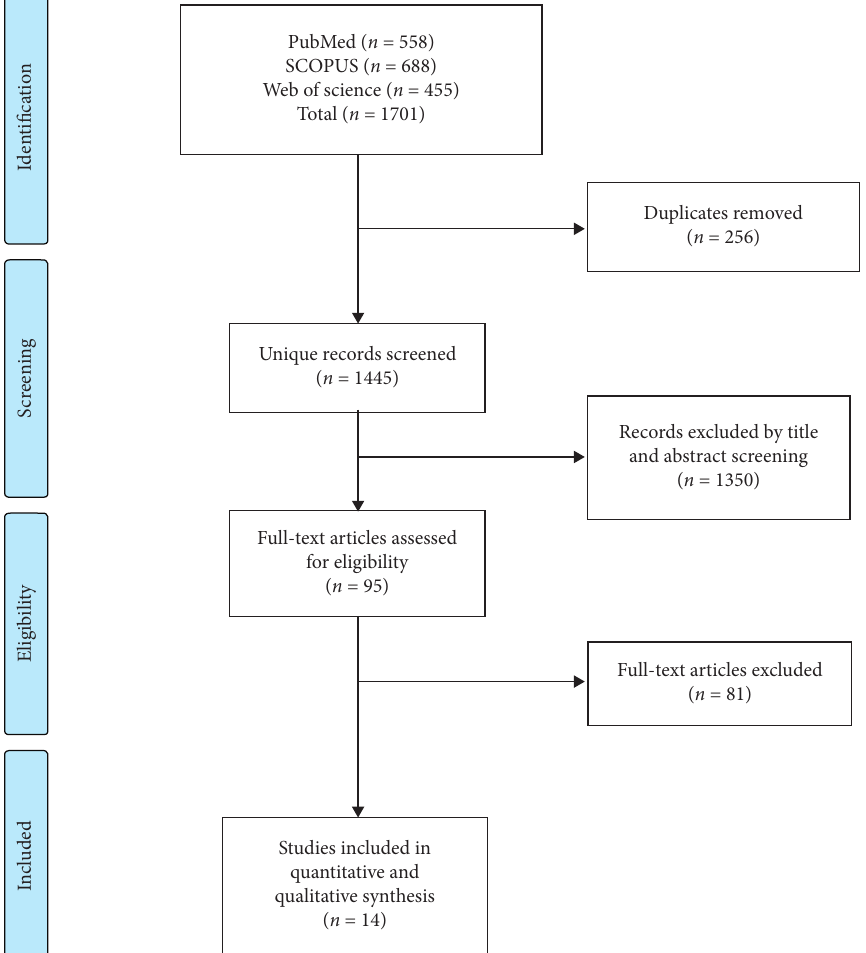
Figure 1: PRISMA flow